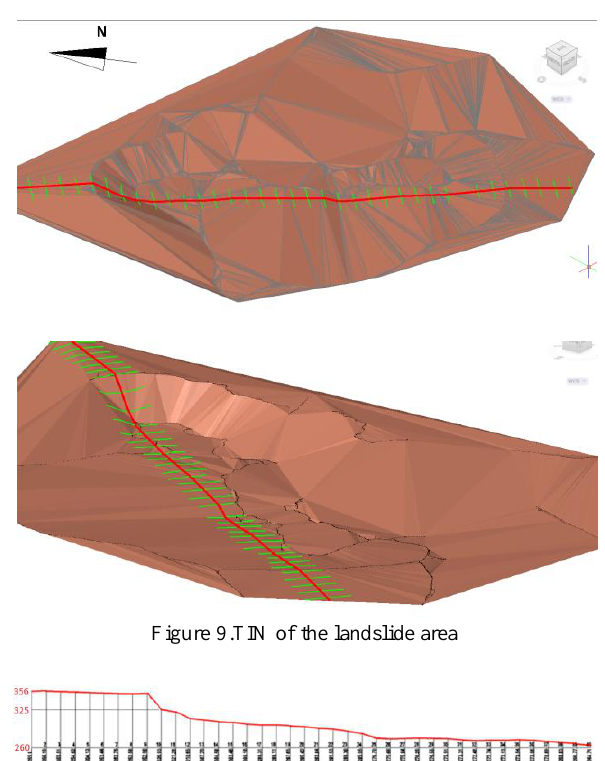
Figure 10. Cross section along the tomography